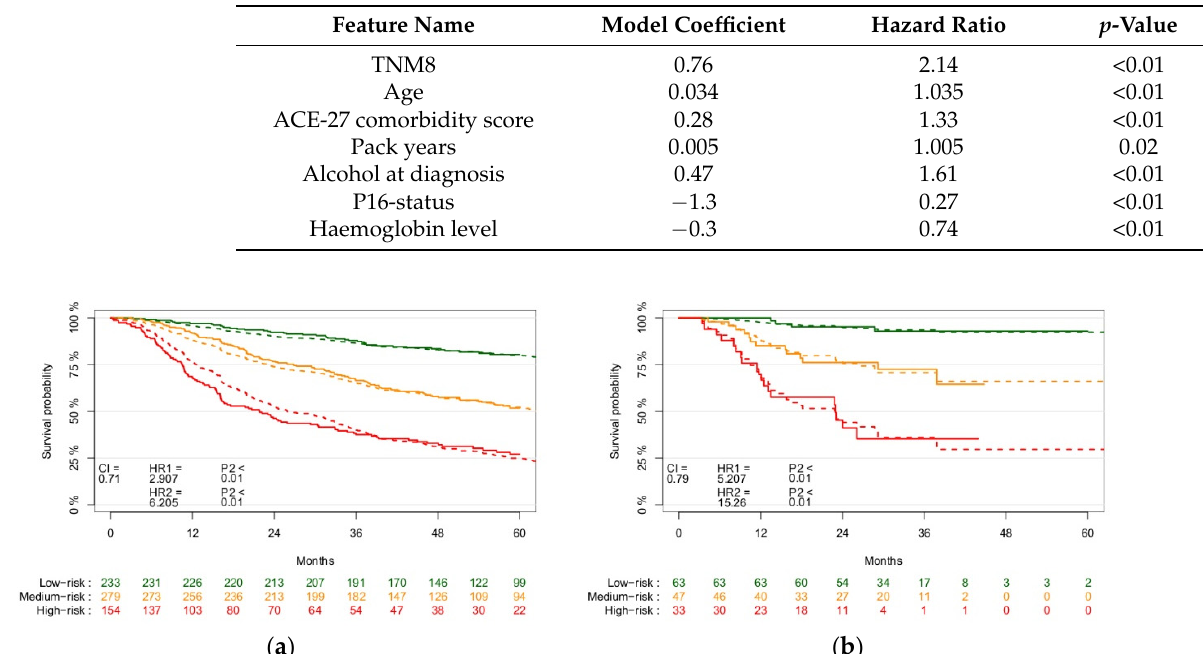
Table 2. Selected clinical and biological features in the clinical, biological, and combined models, with univariate model coefficient, hazard ratio, and significance to outcome shown.